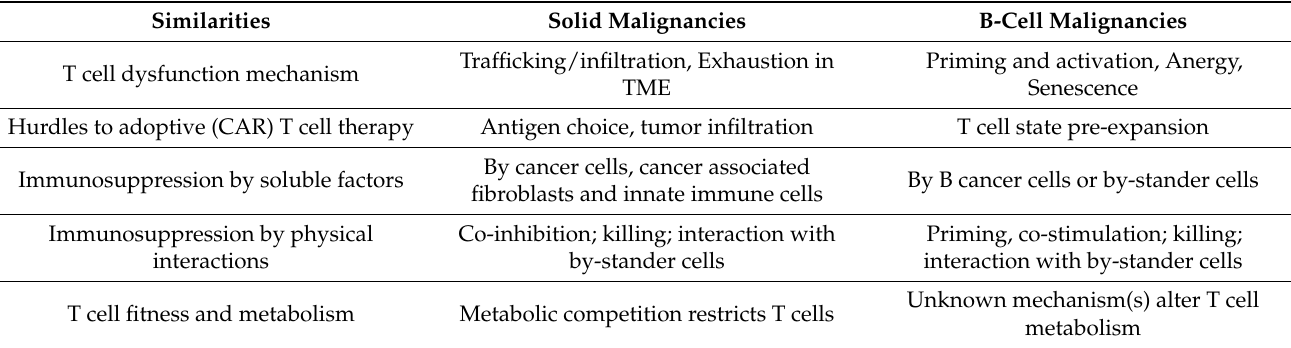
Table 1. Similarities and distinctions in T cell dysfunction in solid versus hematopoietic cancers.